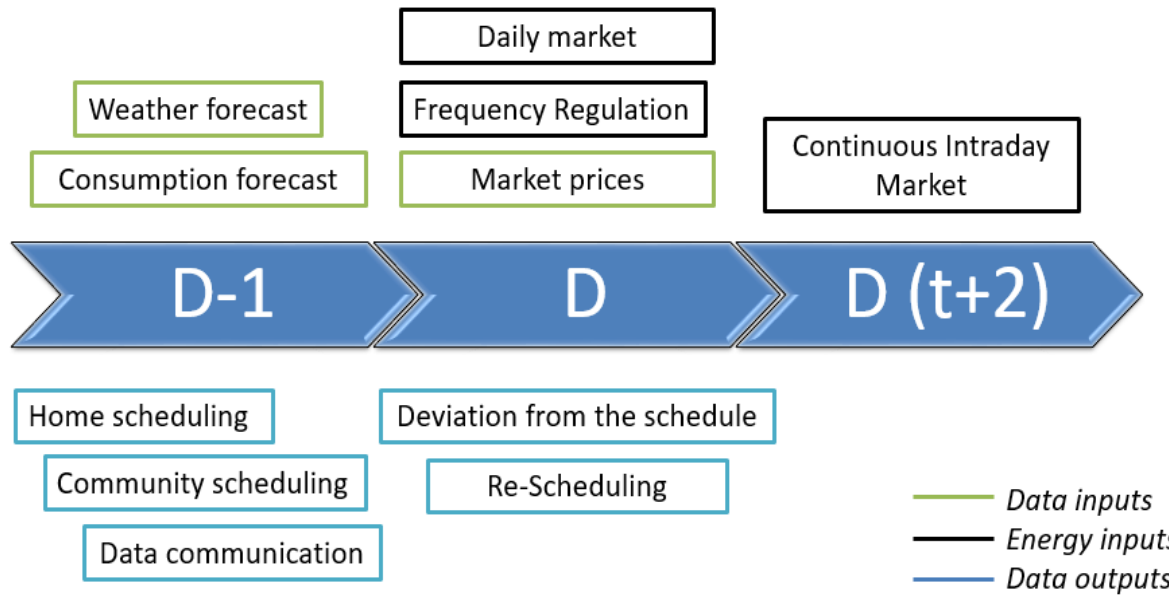
Figure 1. Two-stage scheduling of the energy community.